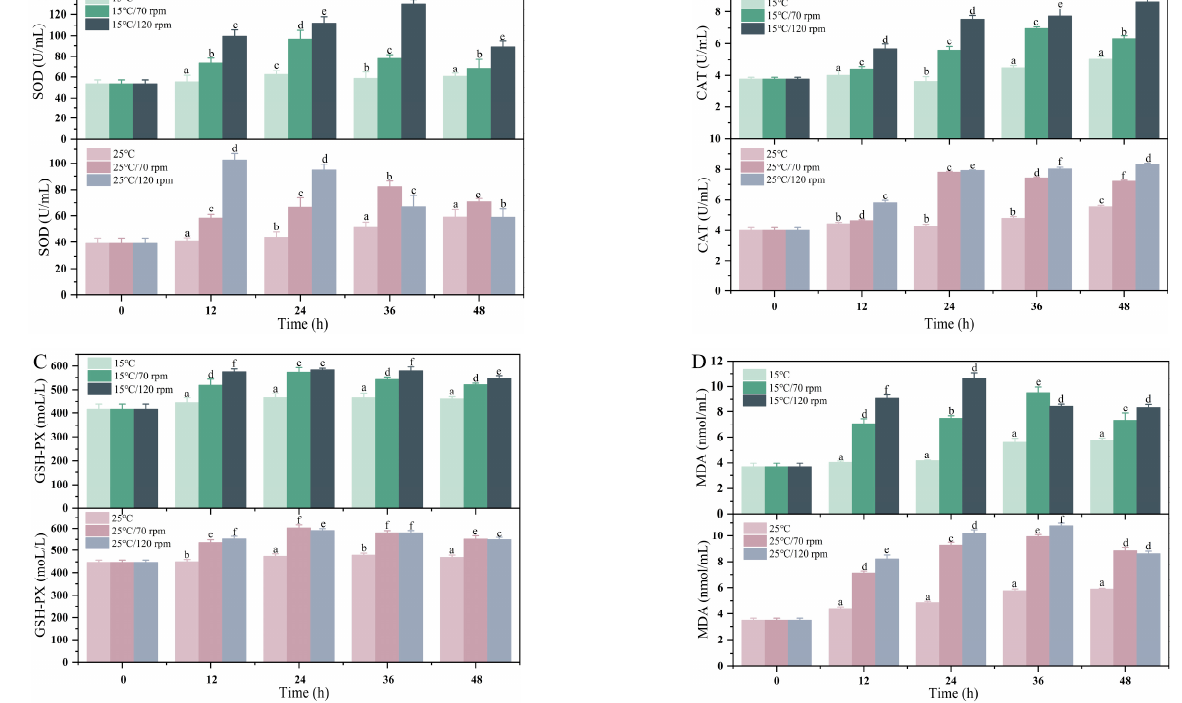
Figure 4. Changes in ( A ) liver SOD, ( B ) CAT, ( C ) GSH-PX, and ( D ) MDA during transport. Values were obtained from average of all samples and given as means ± SD (n = 5). Di ff erent le tt ers above were obtained from average of all samples and given as means ± SD (n = 5). Different letters above the bars indicate signi fi cant di ff erences among the treatments. the bars indicate significant differences among the